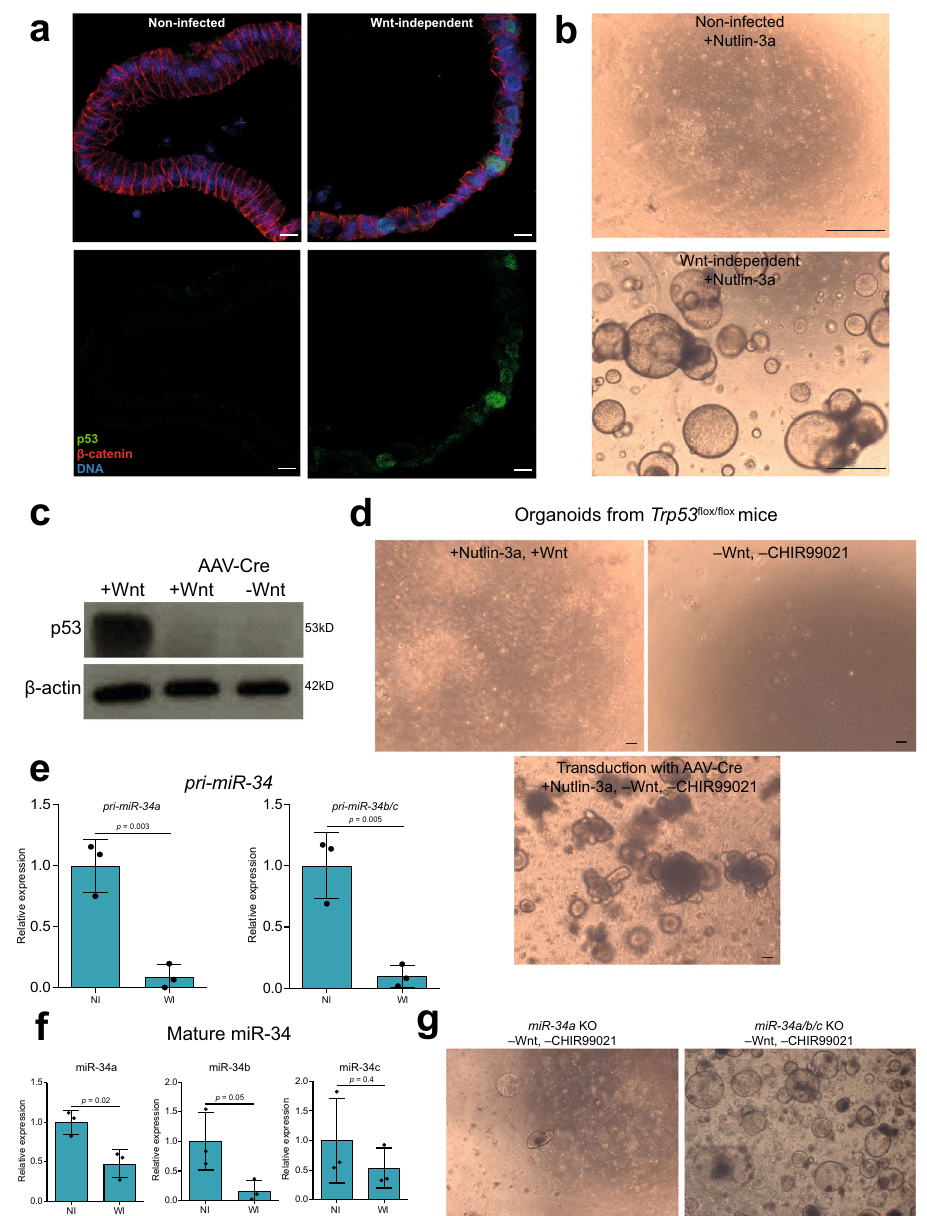
Fig. 5 The Trp53/miR-34 axis is disrupted in the Wnt-independent organoids. a Organoids immunostained for p53 (green) and β -catenin (red). DAPI (blue) was used to stain for DNA. Image representative of three independent replicates. Scale bars: 10 μ m. b Wnt-independent organoids grow in the presence of Nutlin-3a in the medium. Image representative of three independent replicates. Scale bars: 1 mm. c Western blot to verify knockout of Trp53 in organoids after transduction with AAV-Cre. Image representative of two independent replicates. d Organoids from Trp53 fl ox/ fl ox mice grow in the presence of Nutlin-3a and absence of Wnt and CHIR99021 only when transduced with AAV-Cre. Image representative of two independent replicates. Scale bars: 100 μ m. e RT-qPCR data showing expression of pri-miR-34 relative to TUBB from three independent replicates. Data represent mean ± SD, p < 0.05, as calculated by two-sided unpaired Student ’ s t -test. NI = non-infected and WI = Wnt-independent. f RT-qPCR data showing expression of mature miR-34 relative to U6 from three independent replicates. Data represent mean ± SD, p < 0.05, as calculated by two-sided unpaired Student ’ s t -test. NI = non- infected and WI = Wnt-independent. g Organoids from miR-34a KO mice do not grow in the absence of Wnt and CHIR99021, whereas organoids from miR-34a/b/c KO mice do grow in the absence of Wnt and CHIR99021. Image representative of two independent replicates. Scale bars: 1 mm. Source data are provided as a Source Data fi concordance with previous work showing a functional overlap frequently seen in advanced stages of cancer may arise at very between these pathways 39 . TP53 mutations are known to occur early stages in the sequence of transforming events, yet have early in a subset of CRC, such as colitis-associated cancer 7 . Given escaped attention. Mutations affecting miR-34a , as generated here the diversity of mutational patterns conferring Wnt-indepen- by pks + E. coli , may be such an example. Therefore, our data dence, considered as the hallmark of colon cancer initiation, it strongly suggest that disruption of the p53/miR-34 axis, along with seems plausible that mutations other than the APC mutations additional mutations that occurred synergistically, resulted in the